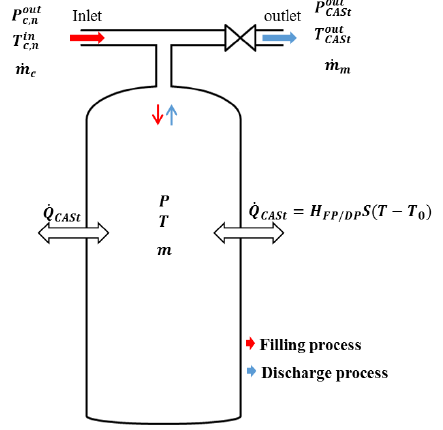
Figure 2. Schematic diagram of compression air storage